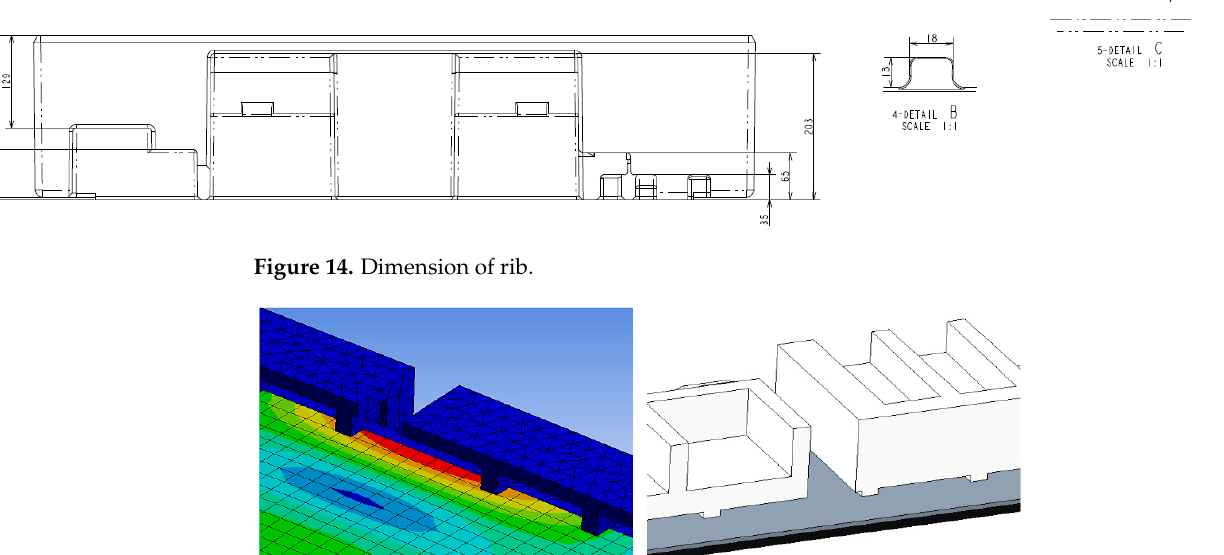
Figure 14. Dimension of rib.